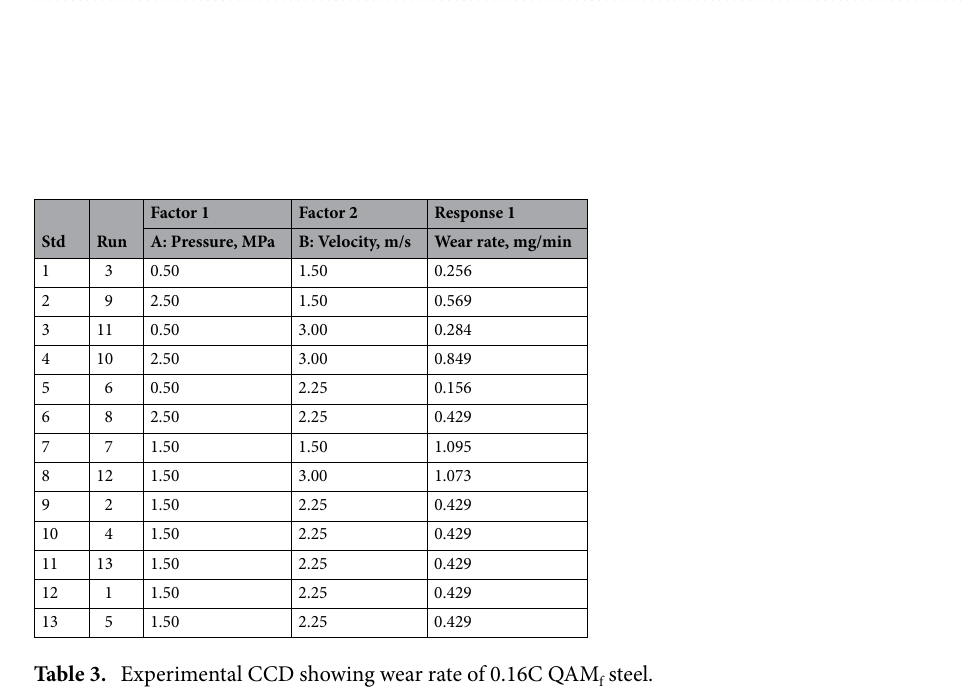
Table 2. Experimental CCD showing wear rate of 0.16C hot rolled steel.